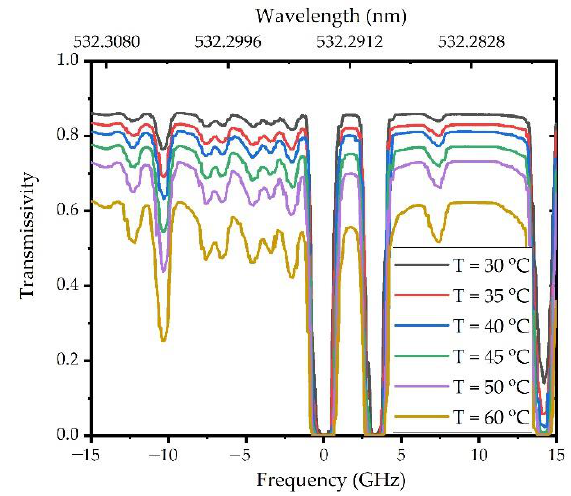
Figure 7. Diagram of the experimental system for Brillouin energy measurement in water.